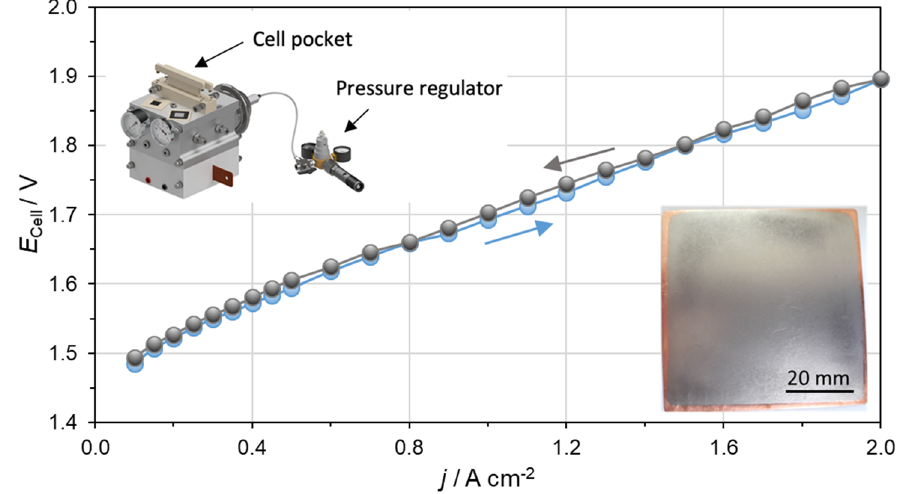
Figure 8. Polarization curve obtained using Nb-coated Cu pole plates, recorded up to 2 A cm − 2 at 80 °C and 8 bar hydraulic pressure. The left inset shows the PEM electrolyzer cell produced by ProPuls used for the test. The right inset shows the Nb-coated Cu pole plate used in the cell.